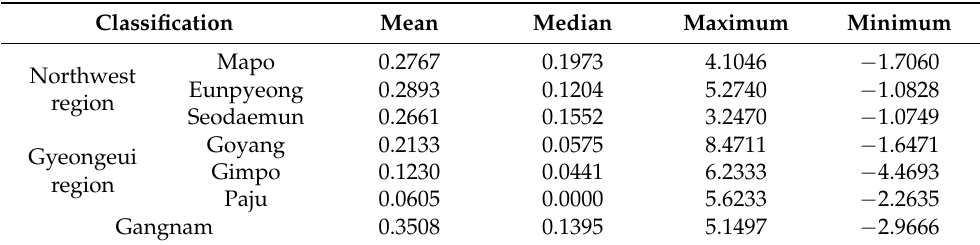
Table 8. Descriptive statistics of sales price change rate.